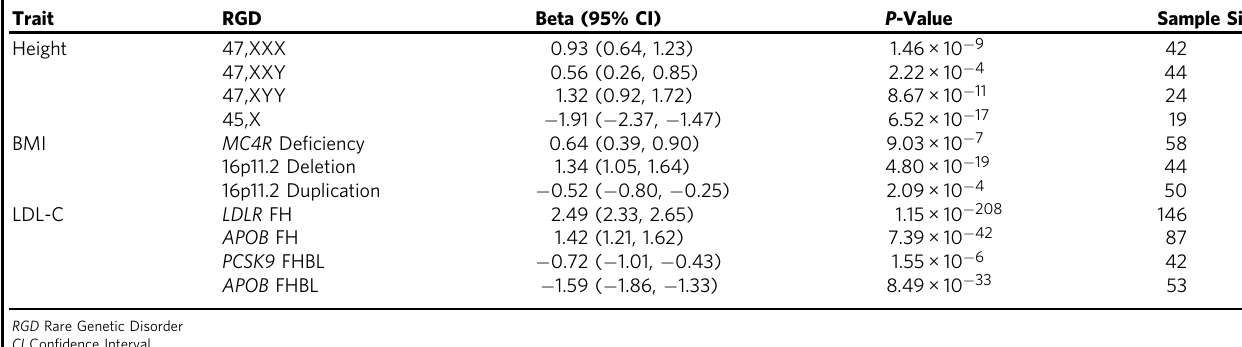
RGD Rare Genetic Disorder CI Con fi dence Interval FH Familial Hypercholesterolemia FHBL Familial